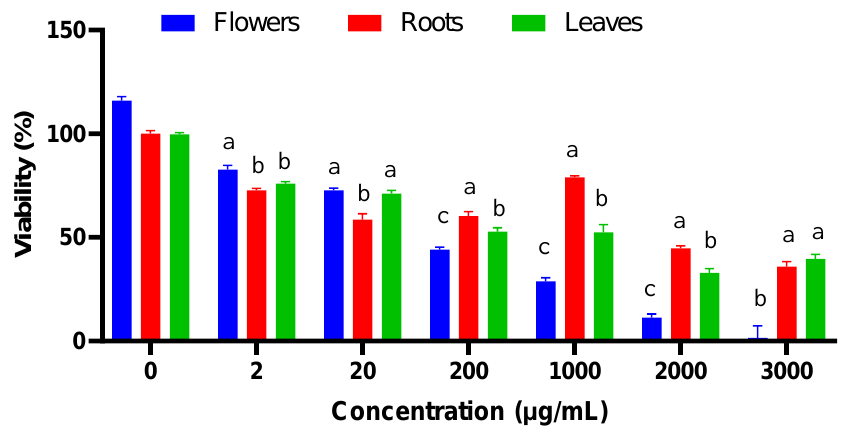
Figure 3. Cytotoxicity of T. balsamita extracts towards THP-1 cells (one-way ANOVA, different letters indicate significant difference between plant parts in the same concentration (a, b and c), p ≤ 0.05).